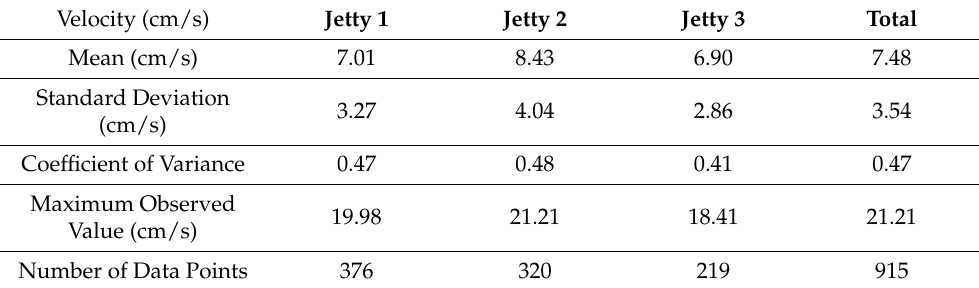
Table 3. Characteristics of the berthing velocity values by jetty.